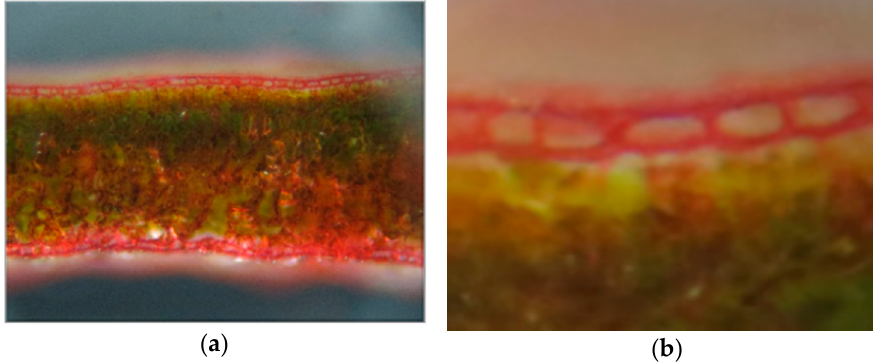
Figure 1. A photograph of a tea leaf cross section stained with safranin. Both the upper and lower epidermis are stained red. ( a ) Whole cross section. ( b ) Enlarged image of the upper epidermis.